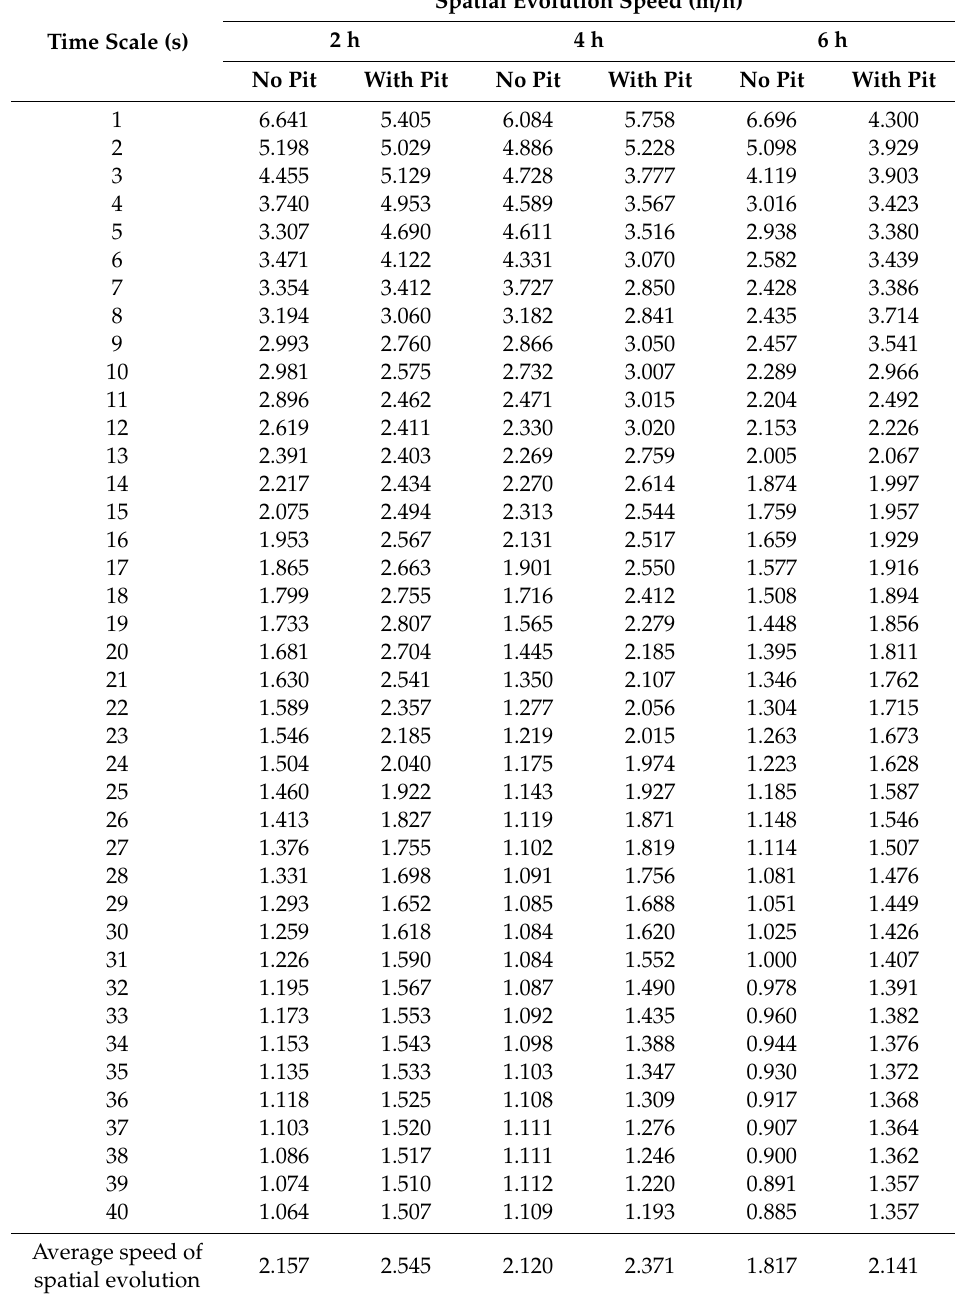
Table 3. Spatial evolution speed of local scour (between upstream and downstream of the pier) for di ff erent time